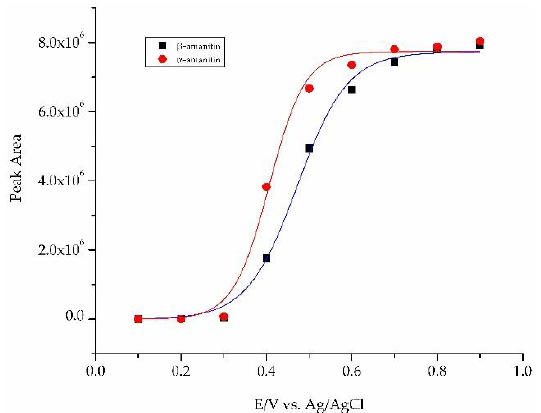
Figure 4. Hydrodynamic voltammograms of α - and β -amanitin standard solutions. Peak areas are plotted versus electrode potentials.